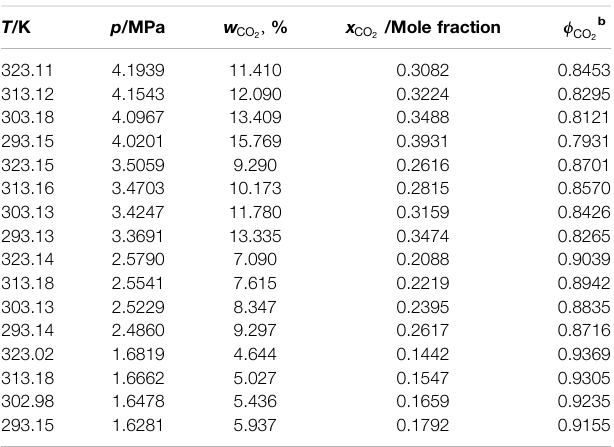
TABLE 3 | Experimental carbon dioxide (CO 2 ) solubility (both in weight percent andinmolefraction x CO )intheL-menthol/thymol(MTH)eutecticsystem w CO 2 2 ) at various temperatures T and and calculated CO 2 fugacity coef fi cient ( ϕ CO 2 pressures p.